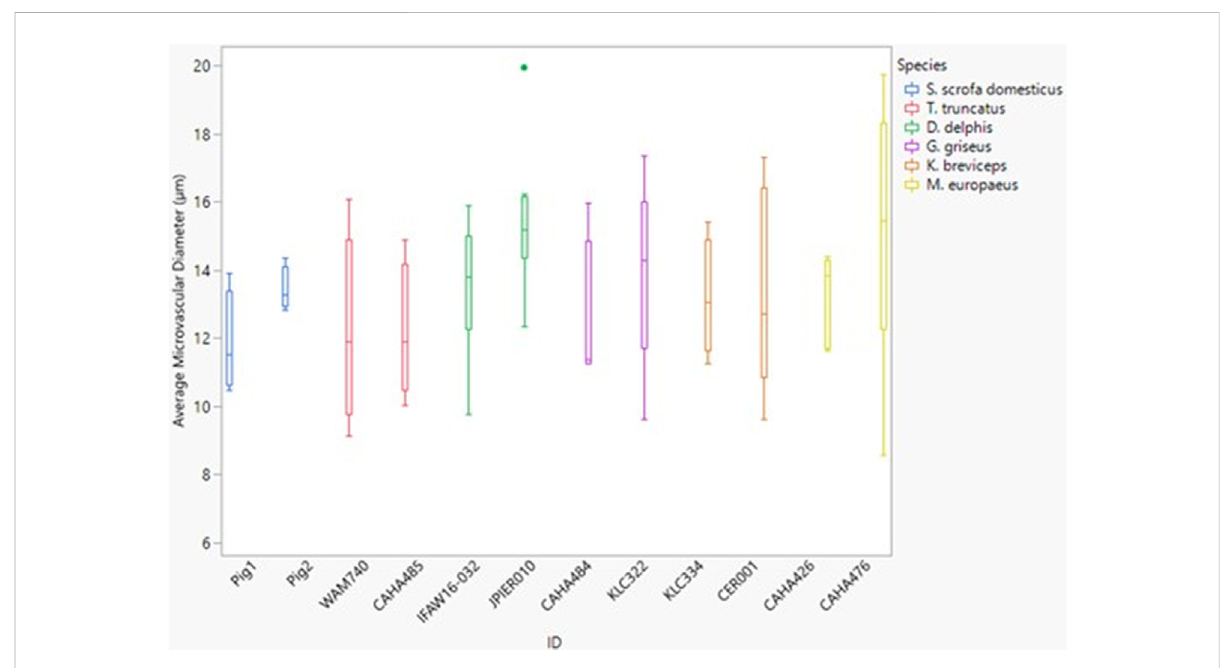
FIGURE 6 Box and whisker plot of average microvessel diameter versus Animal ID color-coded by species. Horizontal lines from top to bottom: maximum, third quartile, median, fi rst quartile, minimum. Dots represent outliers.